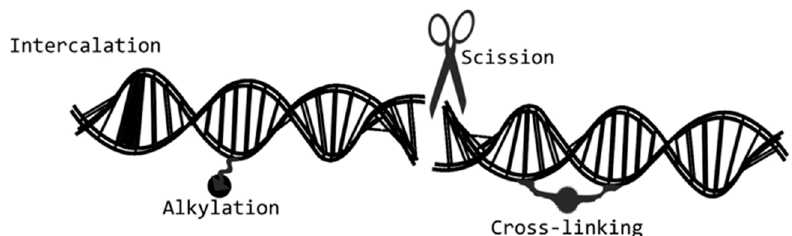
Figure 8. The four main mechanisms of action of DNA-damaging agents: DNA double-strand breakers, DNA alkylators, DNA intercalators, and DNA cross-linkers. DNA-damaging agents. These drugs can act at any phase of tumor cell life cycle.